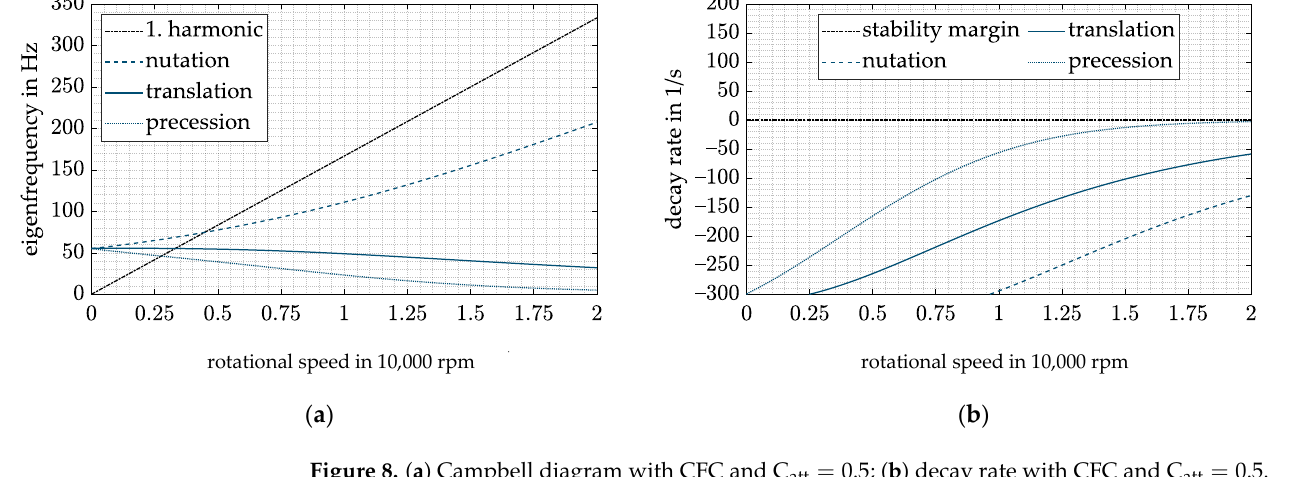
Figure 4. k i and k s against the rotational speed.